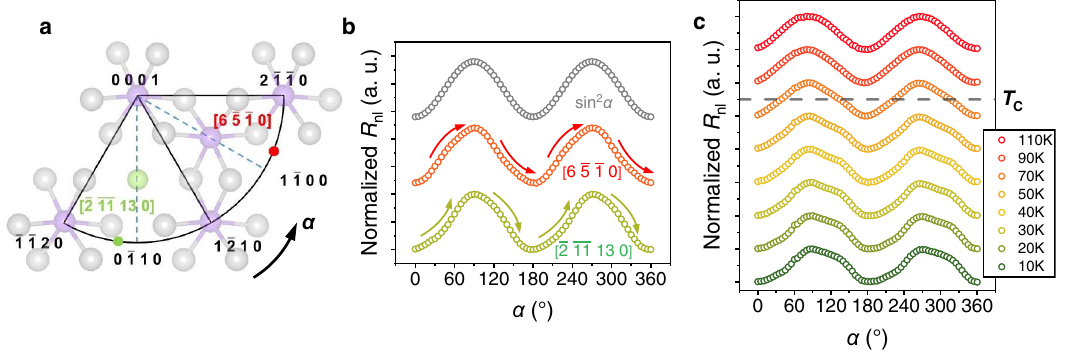
Fig. 5 | Intralayer lattice anisotropy-induced modulation. a Geometry of the intralayer anisotropy in CGT. b Normalized angle-dependent nonlocal resistance ( R nl ) signal injector-detector strip along [6 (cid:1) 5 (cid:1) 10] (red) and [ (cid:1) 2 (cid:1) 11 13 0] (green) crystal